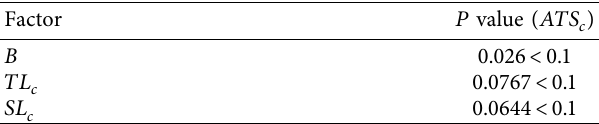
Table 8: ANOVA results (experiment 3).